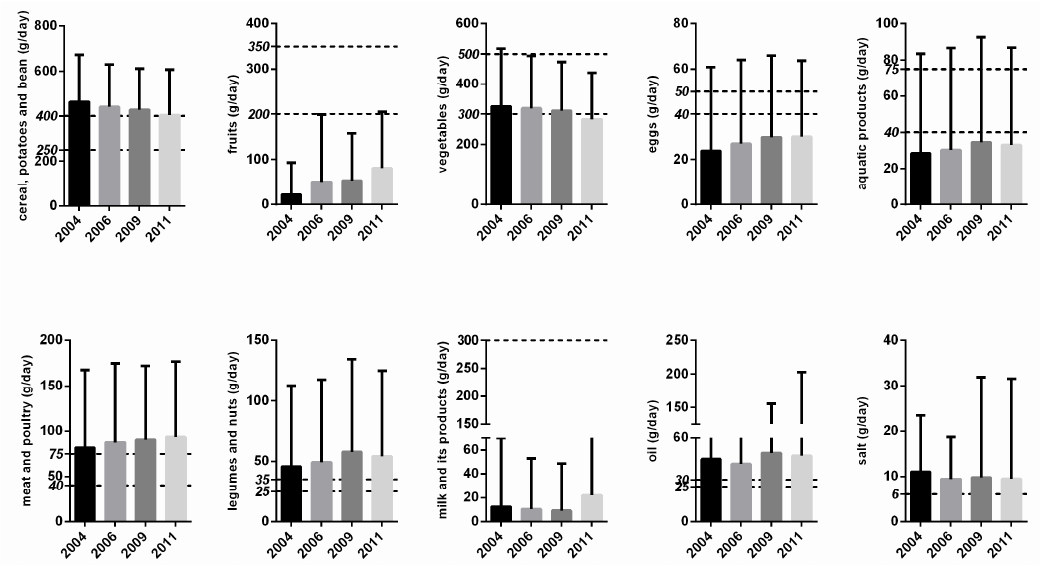
Figure 1. Consumption of individual food groups from 2004 to 2011. Note: The horizontal dashed line refers to the recommended consumption level. The upper line refers to the upper bound, while the lower line refers to the lower bound. The lower and upper bounds for cereal, potato and beans, fruits, vegetables, eggs, aquatic products, meat and poultry, legumes and nuts, milk and its products, and oil are 250/400, 200/350, 300/500, 40/50, 40/75, 40/75, 25/35, 25/30, respectively. Only one standard was set for milk and salt in the Chinese Food Pagoda, which are 300 (lower bound) and 6 (upper bound), respectively. The bar refers to the mean consumption, and the solid black short line above the bar refers to mean ± standard deviation.